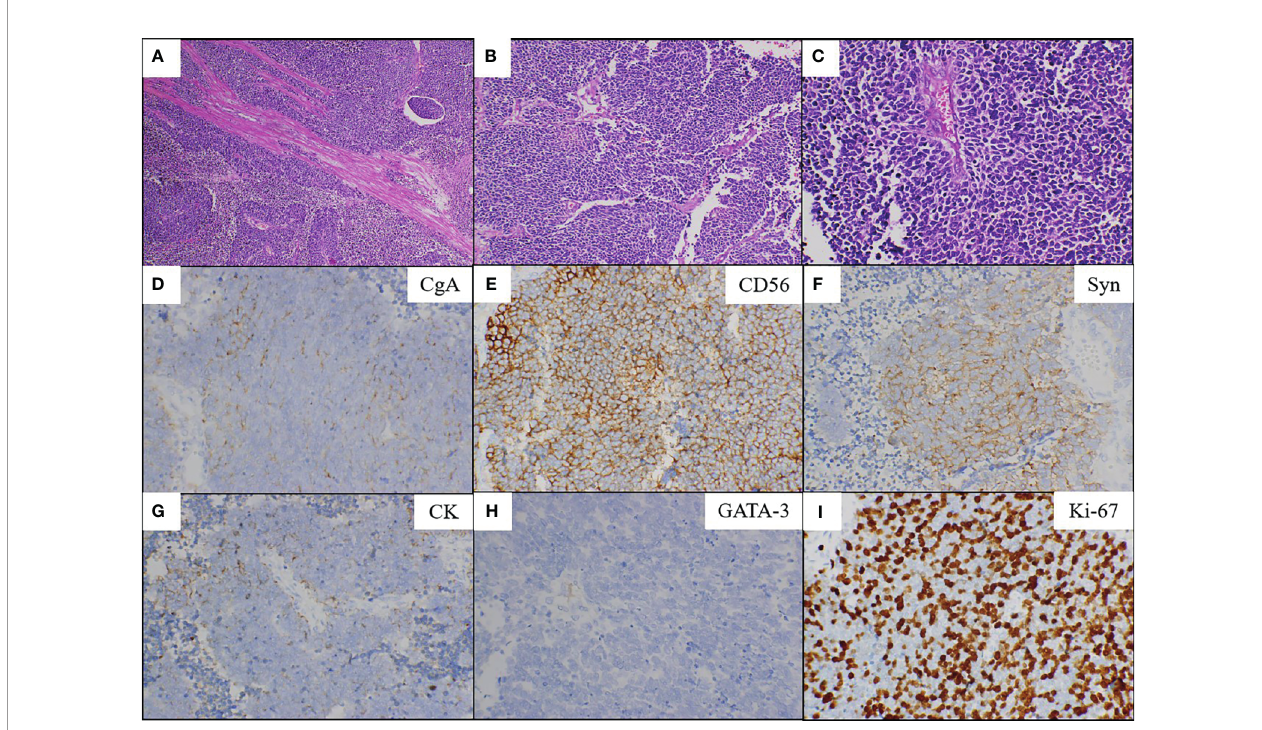
FIGURE 2 | Microscopic fi ndings and immunohistochemical staining. Low ( A ; magni fi cation, x100) and high ( B ; x200, C; x400) power showed the SCNEC (hematoxylin and eosin staining). The tumor is composed of small round cells which had enormous hyperchromatic nuclei and limited cytoplasm with a high nuclear/ cytoplasmic ratio (C) . Positive immunohistochemical staining for chromogranin-A (D) , CD56 (E) , synaptophysin (F) and CK (G) . Negative immunohistochemical staining for GATA-3 (H) . The Ki-67 index was 80% (I) . CgA, chromogranin-A; Syn, synaptophysin; CK, cytokeratin; GATA-3, GATA binding protein